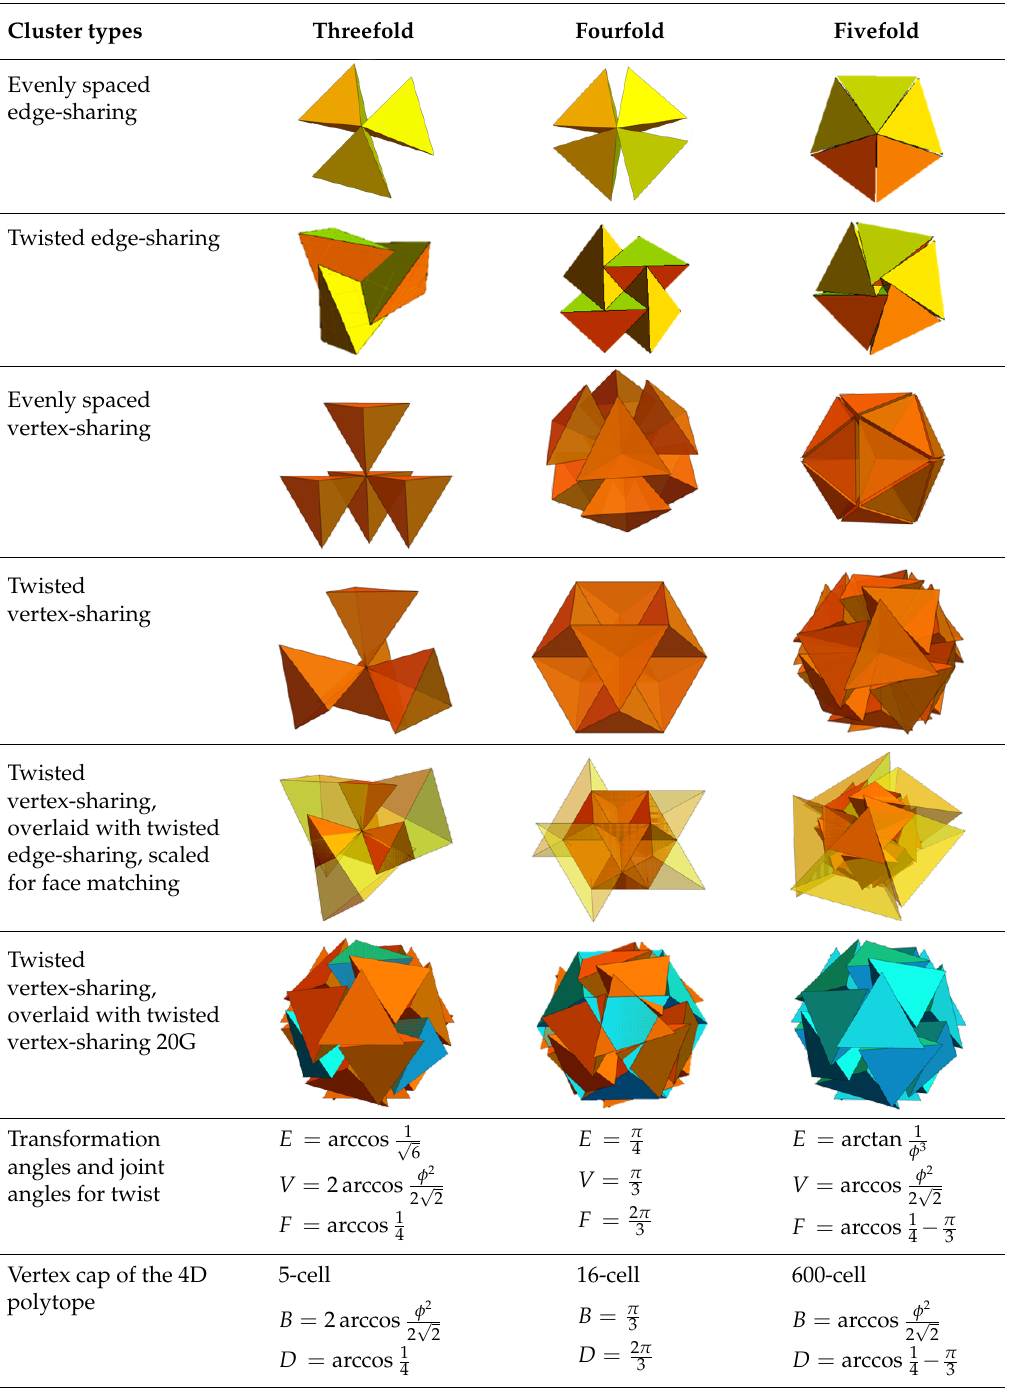
Table 1. Properties of three different types of local tetrahedral clusters and their corresponding 4D polyhedra. Symmetrically arranged configurations with gaps are shown in Row 1 (edge sharing) and Row 3 (vertex sharing). Corresponding twisted configurations are shown in Rows 2 and 4. Rows 5 and 6 show overlays of various twisted configurations. In the last two rows note that, for each column, V = B and F = D . The symbol φ is used for the golden ratio, φ = 1 Materials for dynamical versions of some